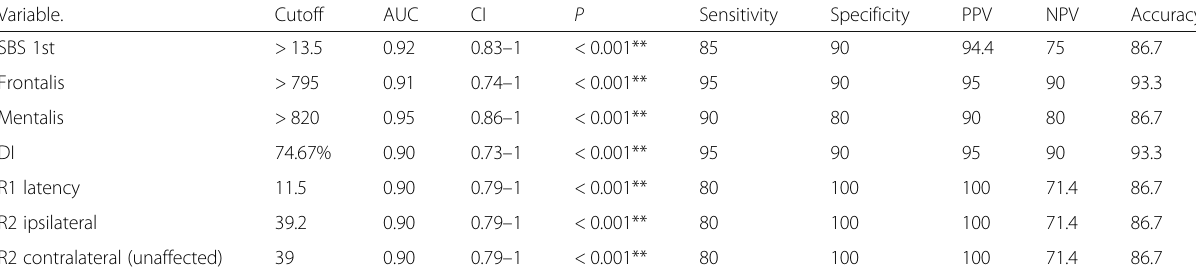
Table 4 Validity of different parameters in prediction of patient improvement among the studied patients